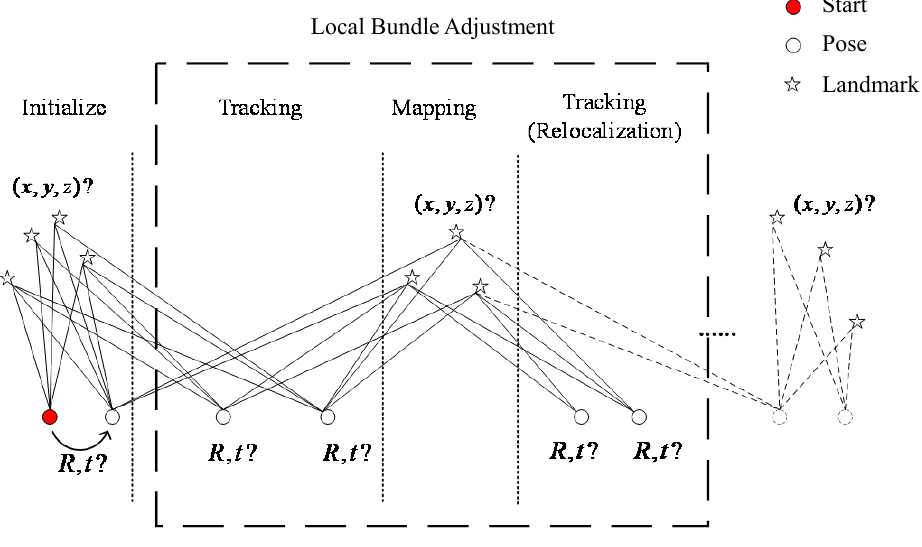
Figure 2. Feature-based V_SLAM local optimization.